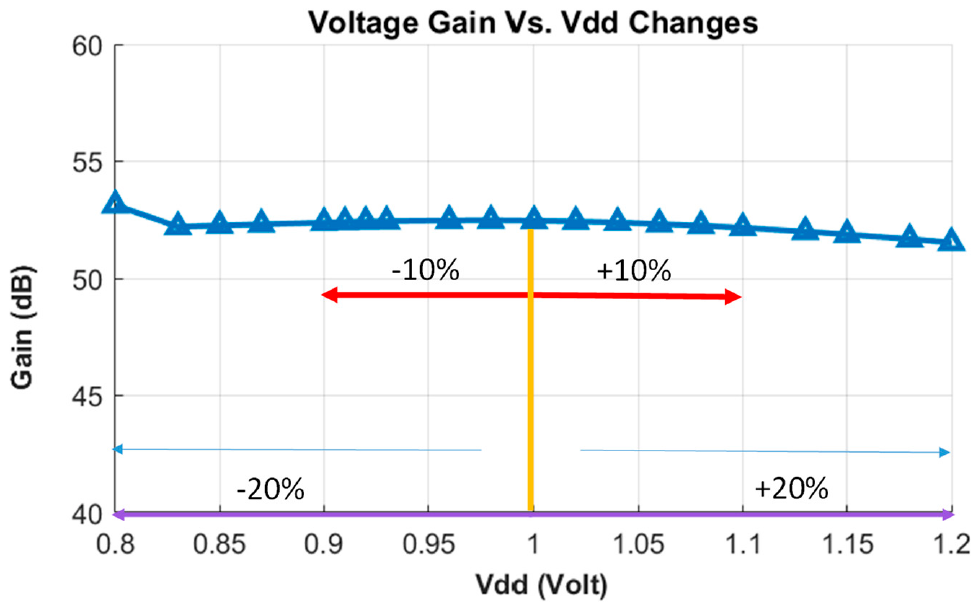
Figure 9. Voltage gain changes in the proposed amplifier due to different power supply voltage ranges.